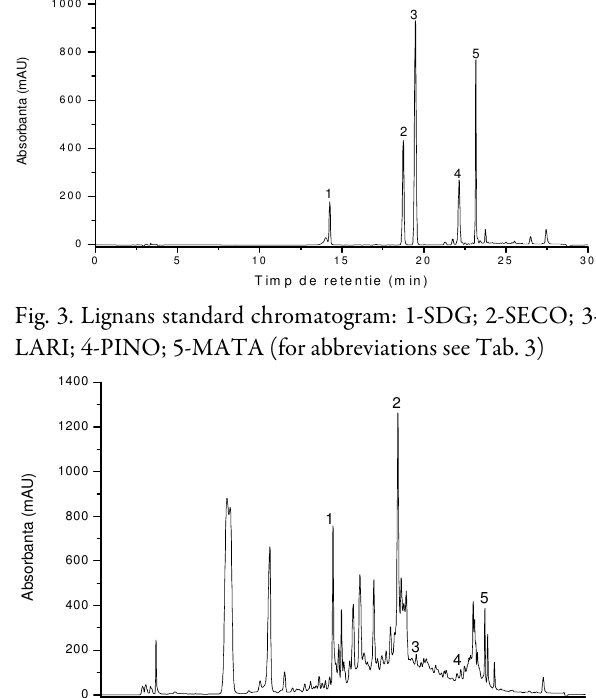
Tab. 3. The lignans quantity in the seeds sample Lignan Secoisolariciresinol diglucoside